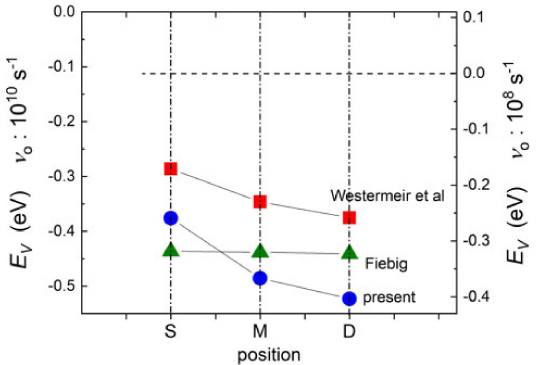
Figure 6. Valence band edge energy E v below the E tp level along the channel of FETs from different laboratories. The energy E v was calculated from Equation (9) using the crossover frequencies ω s of the corresponding I p ( ω ) spectra in Figure 6 of our transistor (circles) and the transistors of Westermeir et al. [12] (squares) and Fiebig [22] (triangles), for ν o = 10 10 s − 1 (left axis) and ν o = 10 8 s − 1 (right axis).